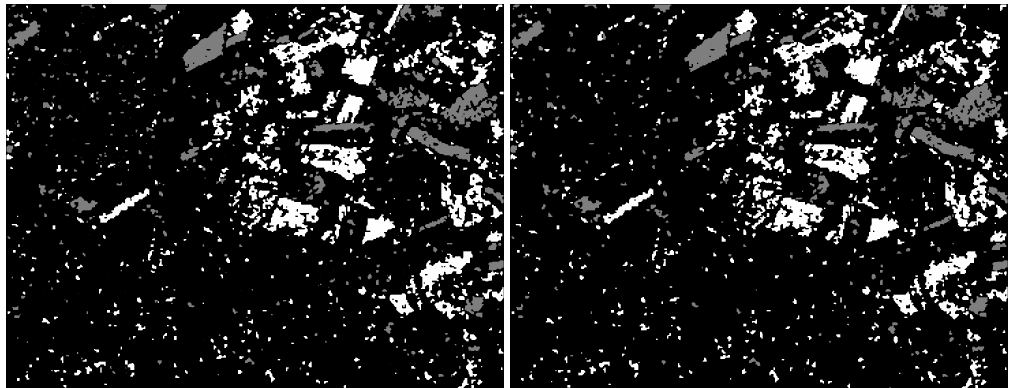
Figure 8. Change maps obtained by applying the single-resolution multi-source MRF method in [10] after upsampling the polarimetric data and stacking them together with the stripmap data. The maps on the left and on the right were obtained when the class-conditional statistics of the amplitude ratio data were modeled using log-normal and Weibull-ratio distributions, respectively. The legend is reported in Figure